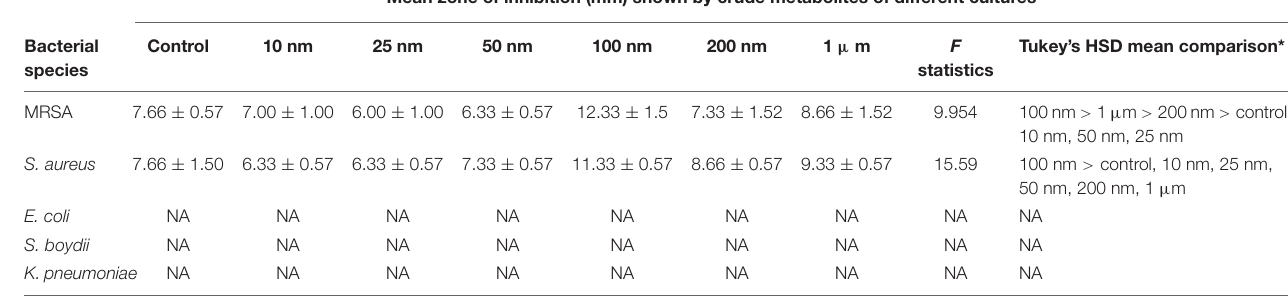
TABLE 1 | Results of one-way ANOVA and Tukey’s HSD mean comparison examining the zone of inhibition against different bacteria using metabolite extracted from treated and non-treated fungus D. longicolla. Mean zone of inhibition (mm) shown by crude metabolites of different cultures Bacterial